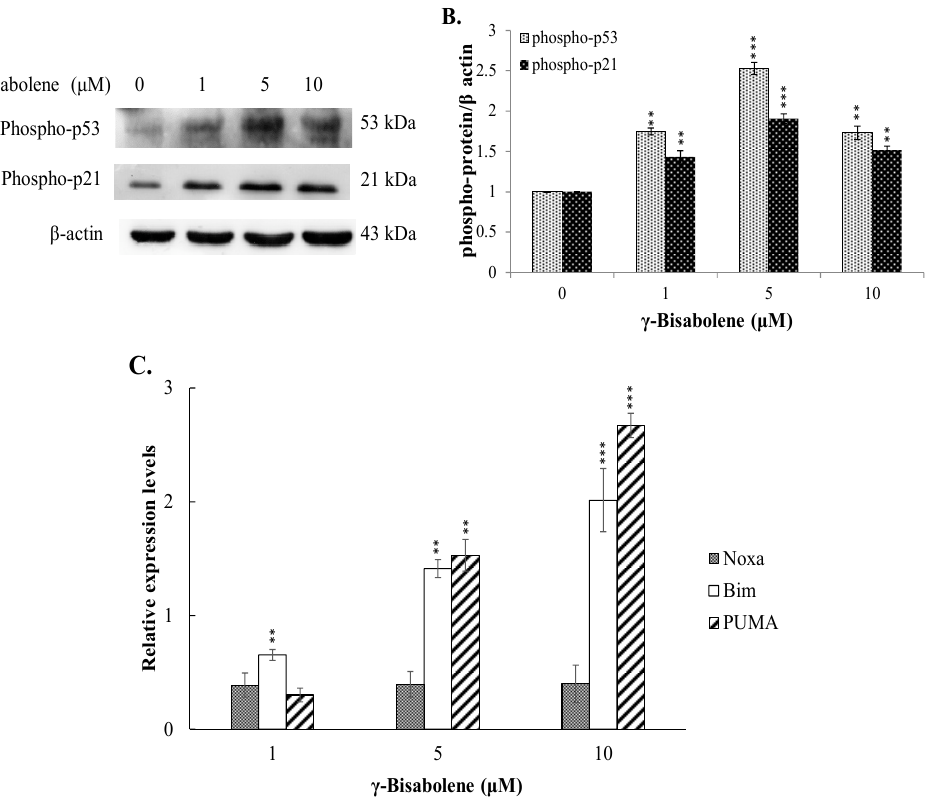
Figure 6. Activation of p53 mediated transcriptional activity by γ -bisabolene. Western blot analysis of lysates from treated and mock cells was performed; the blots were probed with primary and secondary antibodies ( A ); Relative band intensity of phospho-p53 or phosphor-p21 was normalized by β actin, compared to the mock cells, and quantified using imageJ based on triplicate replicates of each experiment ( B ); Relative fold levels in treated and mock cells appear as ratio of indicated mRNA/GAPDH mRNA after performing real time PCR assays ( C ). **, p value < 0.01; ***, p value < 0.001 compared with untreated